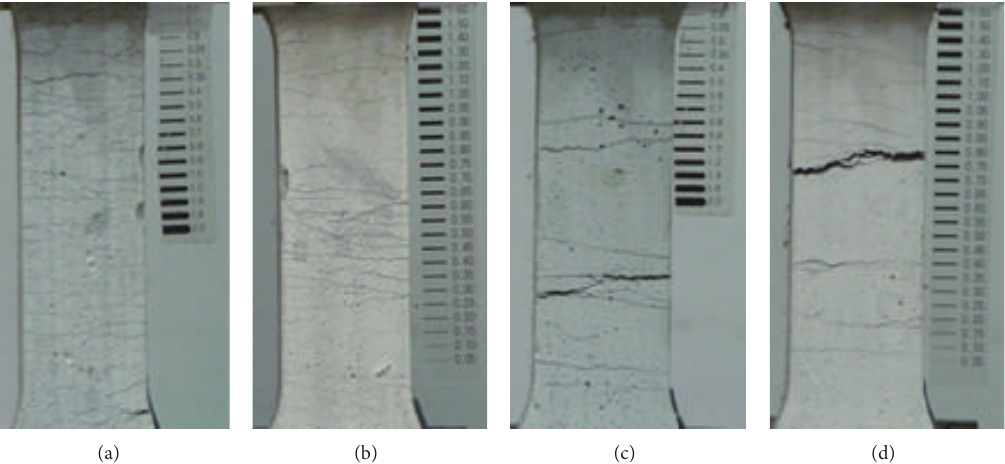
Figure 6: Crack behavior/pattern of ECC. (a) ECC-FASL, (b) ECC-FASL-BA10%, (c) ECC-FASL-BA20%, and (d) ECC-FASL-BA30%.